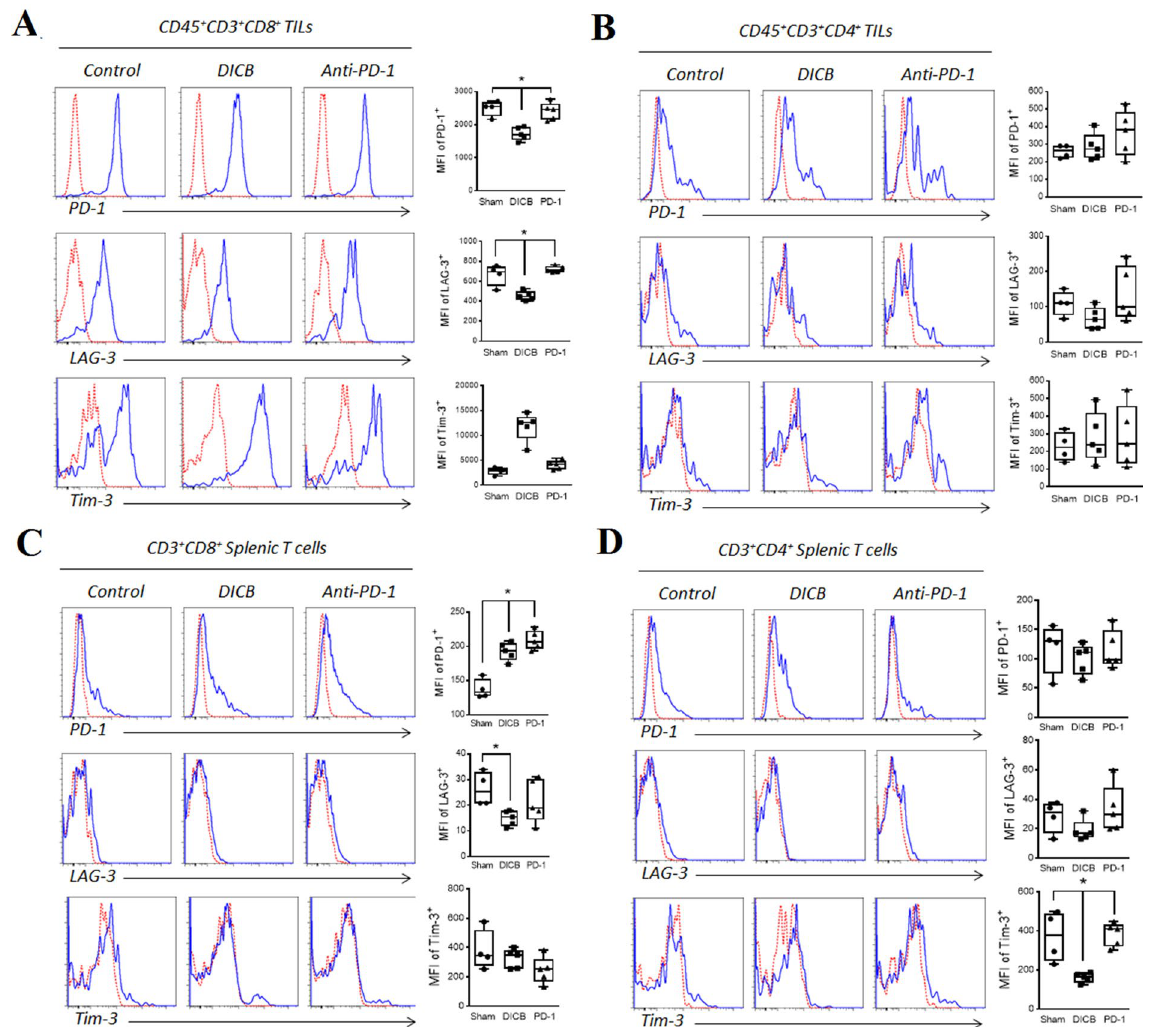
Figure 3. Flow cytometric analysis of co-inhibitory receptors on tumor infiltrating CD8 + T cells ( A ), tumor infiltrating CD4 + T cells ( B ), splenic CD8 + T cells ( C ), and splenic CD4 + T cells ( D ) shown as histograms of mean fluorescence intensity (MFI) with matching box and whisker plots. Significance of p < 0.05 is denoted with an